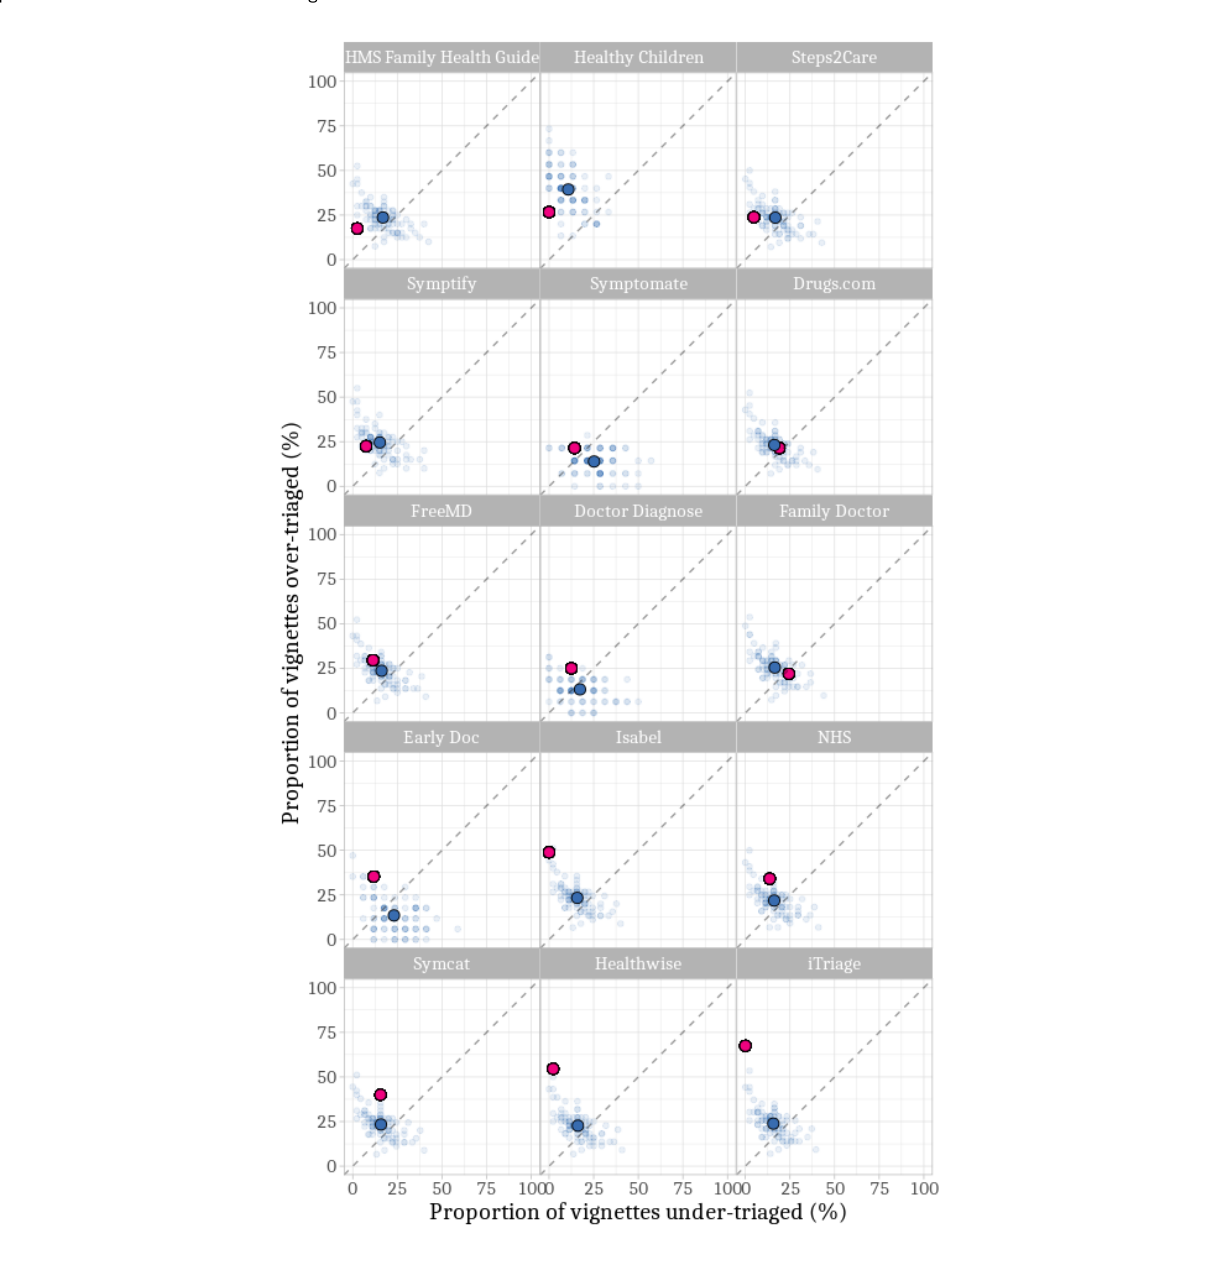
Figure 4. Comparison of the overtriage inclination of symptom checkers (SCs) and participants. The dashed line shows where proportions of over and undertriaged errors are equal. Proximity to the left lower corner indicates a high triage accuracy. The red dot marks the respective symptom checker. The faded blue dots refer to the performance of individual participants. The larger blue dot marks their average performance. The SCs are ordered from left to right and top to bottom by the proportion of participants outperforming them, with the lowest proportional difference at the top left and the highest proportional difference on the bottom